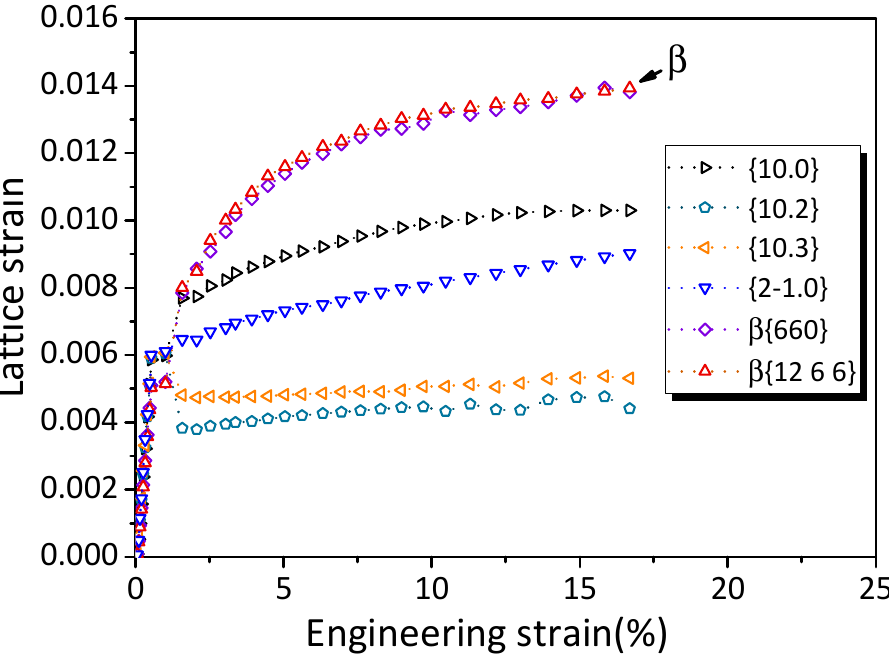
Figure 4. Lattice strain evolution with engineering strain for the β and α -Mg peaks along the tensile/axial direction.